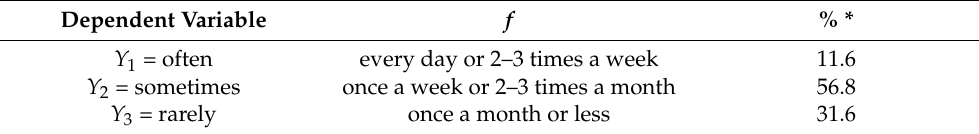
Table 2. Categorization of the fish consumption